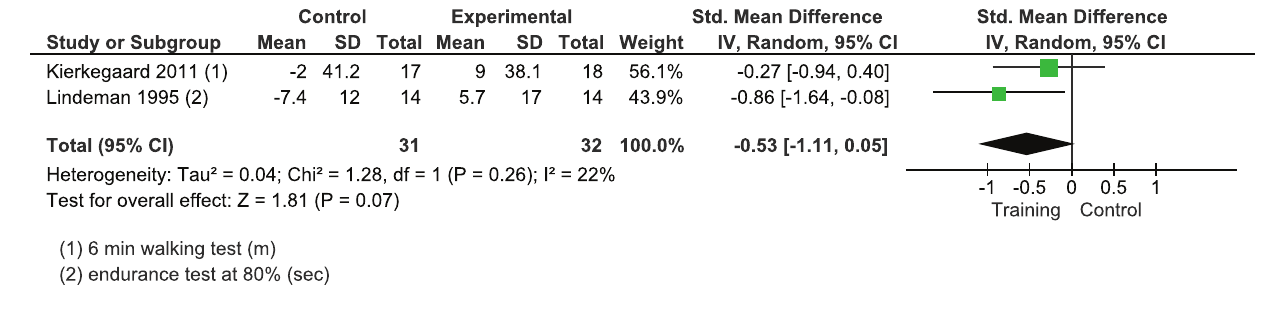
Figure 6. Effect of muscular exercise on endurance.